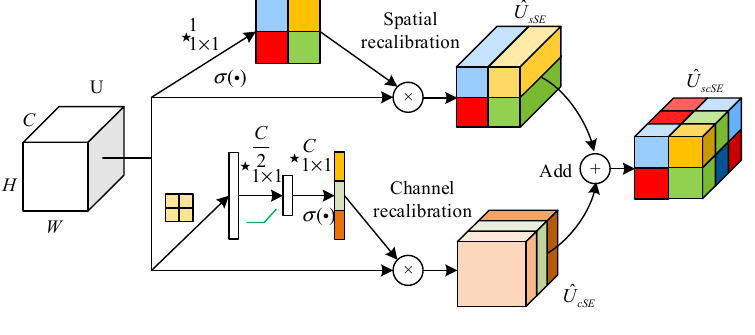
Figure 14. scSE block.